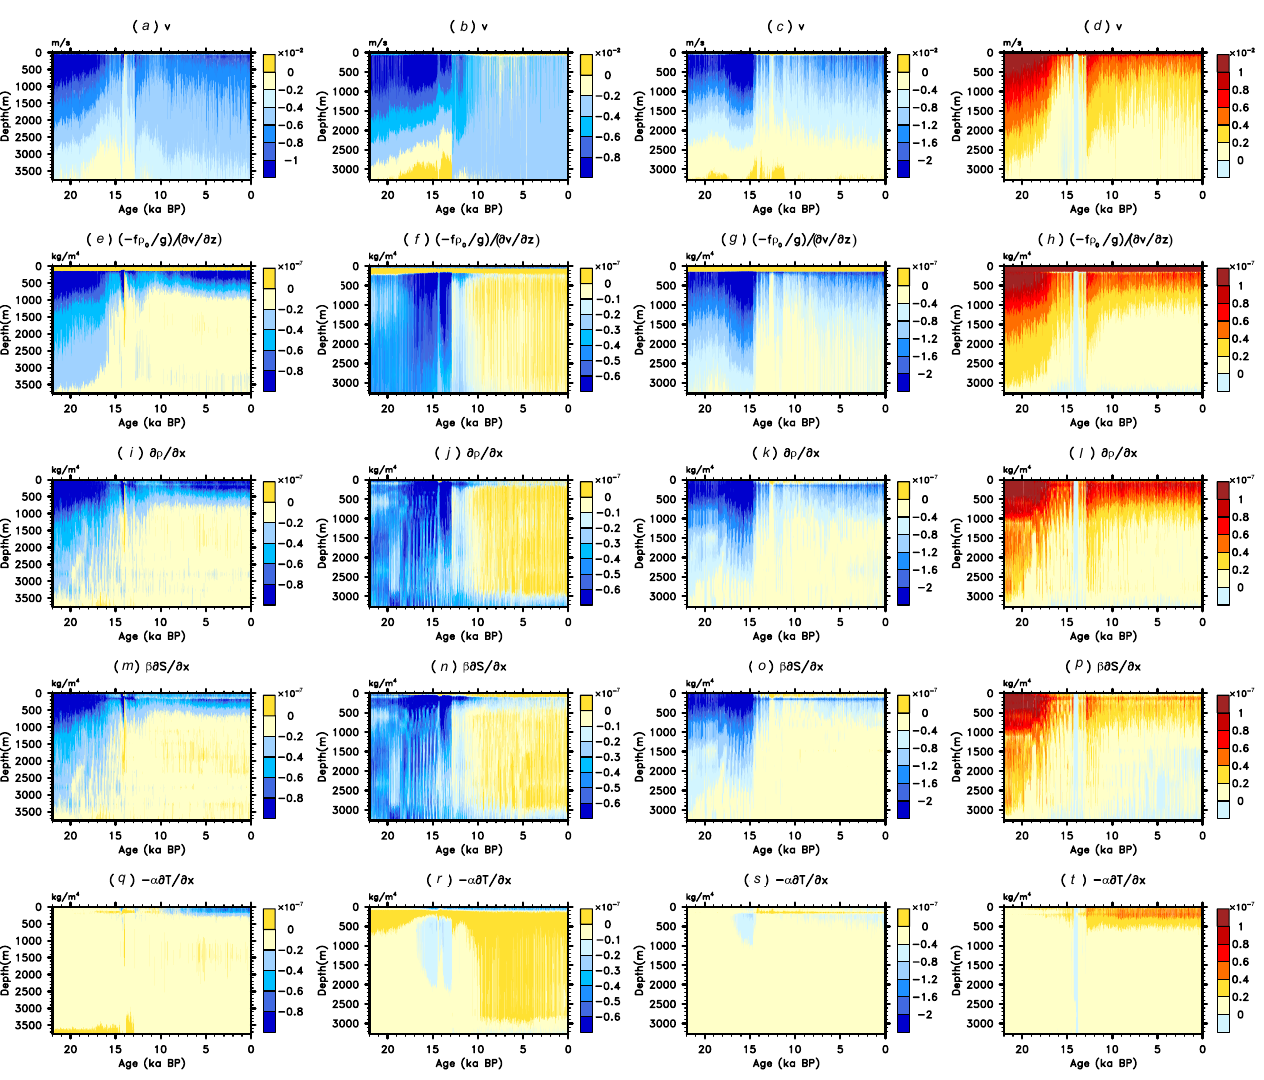
Figure 7. Depth-time diagrams for cores A–D during the last 22,000 years: ( a – d ) the meridional velocity v (shading in 10 − 2 m/s) , ( e – h ) the vertical shear of v which is scaled for zonal density gradient via the thermal wind relationship: ( − f ρ ) / ( ∂ v / ∂ z ) (shading in 10 − 7 kg/m 4 ) , ( i – l ) the zonal density gradient ∂ρ / ∂ x (shading in 10 − 7 kg/m 4 ), ( m – p ) the 0 / g haline contribution to zonal density gradient ∂ρ / ∂ x : β ( ∂ s / ∂ x ) (shading in 10 − 7 kg/m 4 ) and ( q – t ) the thermal contribution to zonal density gradient ∂ρ / ∂ x : − α ( ∂ t / ∂ x ) (shading in 10 − 7 kg/m 4